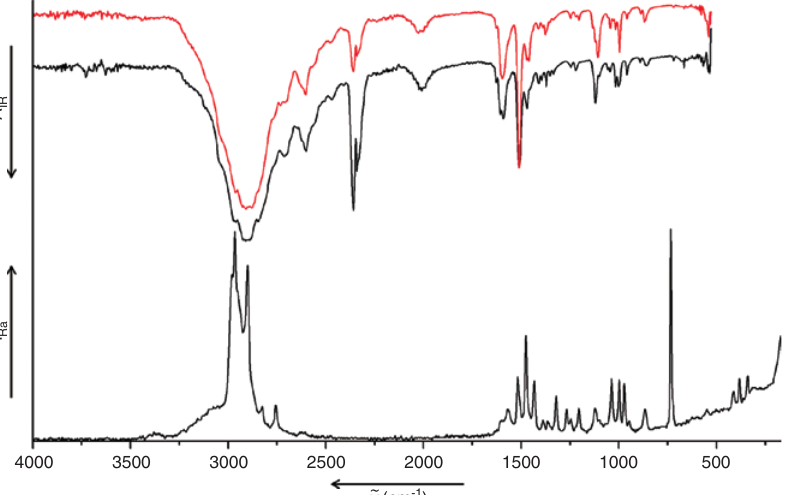
Figure 4: Upper part: IR spectra of the monoclinic polymorph 6a (red) and of the tetragonal polymorph 6b (black). Lower part: Raman spec- trum of a cross-section sample of both